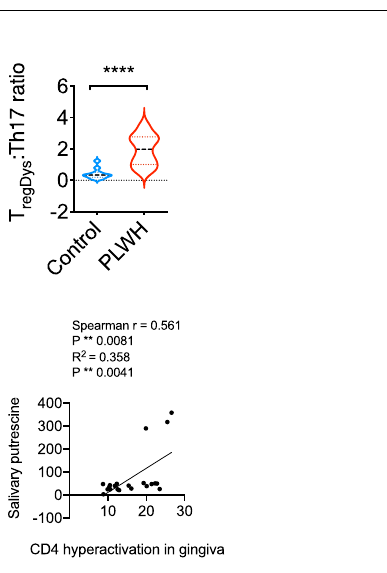
Fig. 8 | Exogenous addition of polyamines causes EIF5A upregulation, EIF5A hypusinationleadingtoinductionofT regDys cellsandtheirproliferation. HTOC CD4 + T cells were TCR stimulated in the presence of GC7 (10 μ M), Putrescine dihydrochloride(100 μ M),orSpermidine(1mM)withoutinfection.Flowcytometry histogram overlays (top) and statistical quanti fi cation of MFIs (bottom) based on